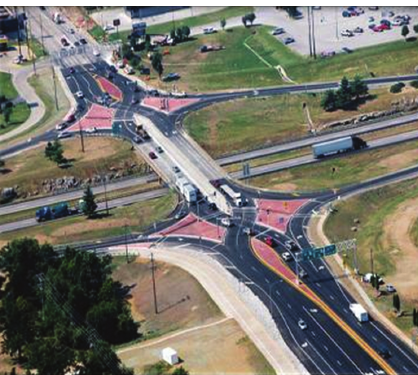
Figure 1: Diverging diamond interchange in Springfield, Missouri.